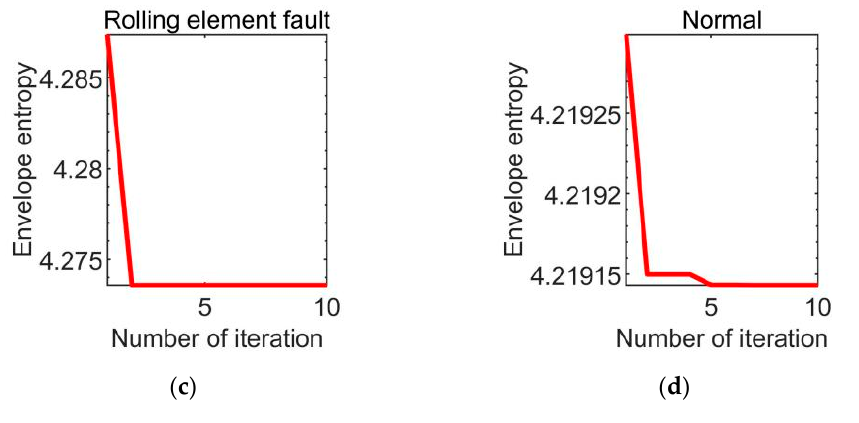
Figure 6. The optimized VMD curve with WOA. Table 2. The optimization parameters obtained by using the WOA. Normal Inner Race Outer Race Rolling Element